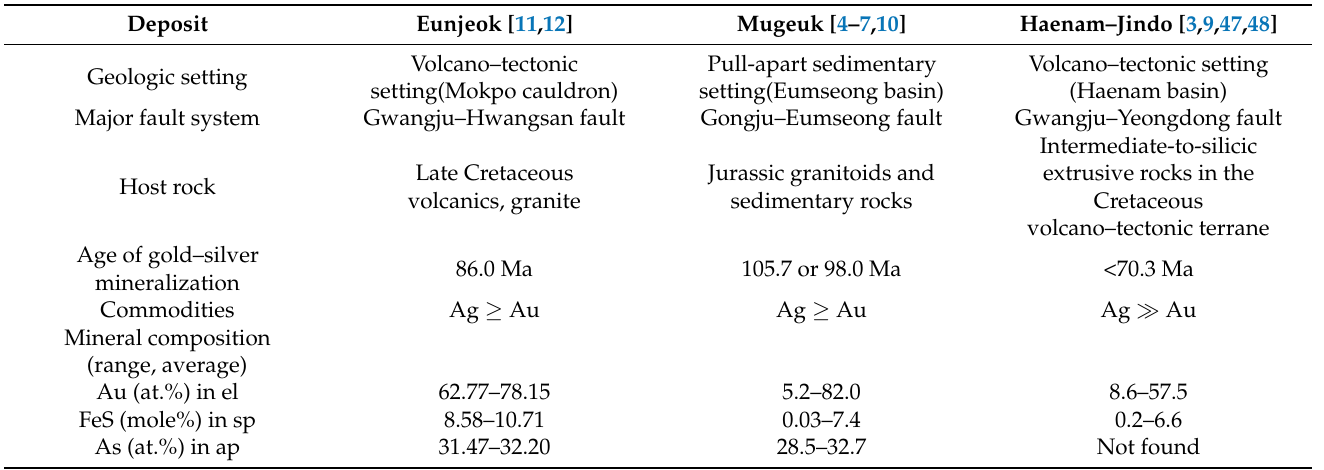
Table 8. Comparison of general characteristic features, mineral composition, fluid inclusion, and stable isotope data for the representative Cretaceous gold–silver deposits in South